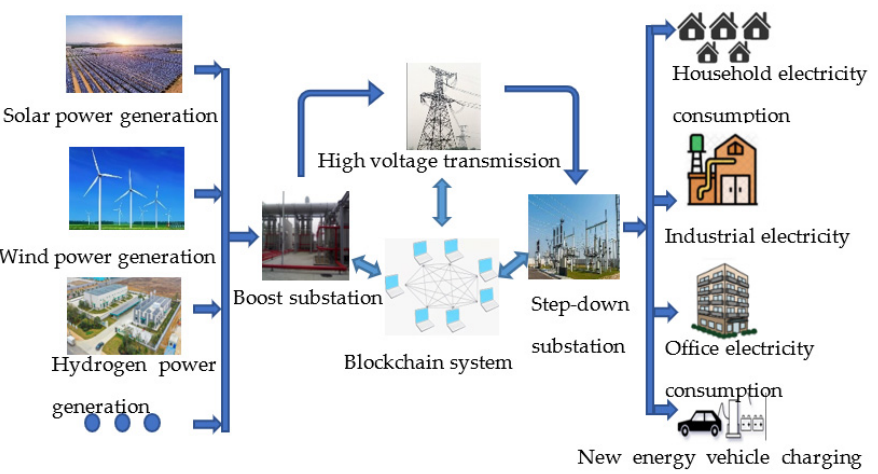
Figure 9. Application of the blockchain technology in power transmission and distribution.